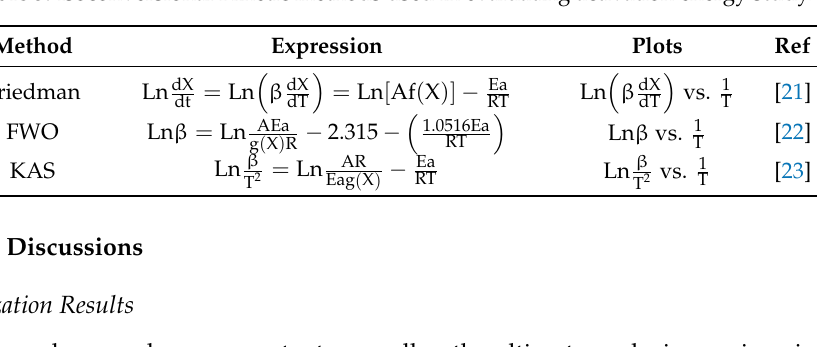
Table 5. Isoconversional Kinetic methods used in evaluating activation energy study.